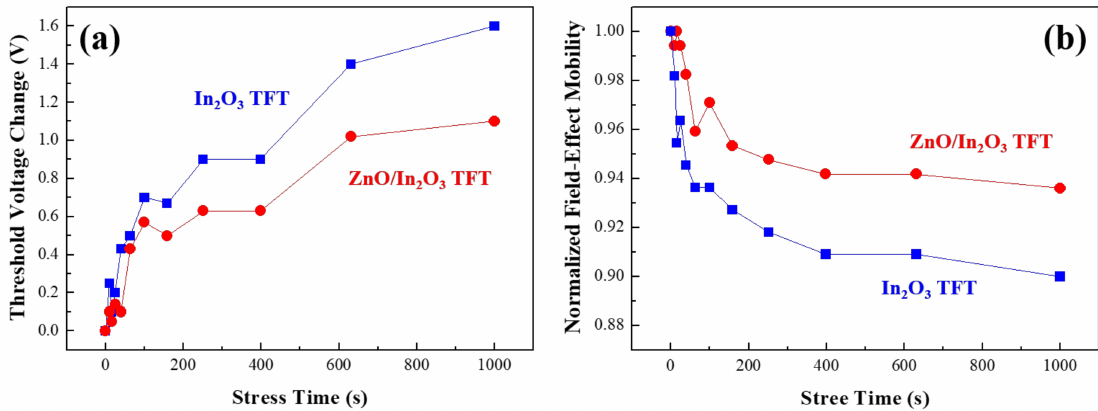
Figure 8. Variations in ( a ) threshold voltage and ( b ) field-effect mobility of the In 2 O 3 and ZnO/In 2 O 3 TFTs as a result of negative gate-bias